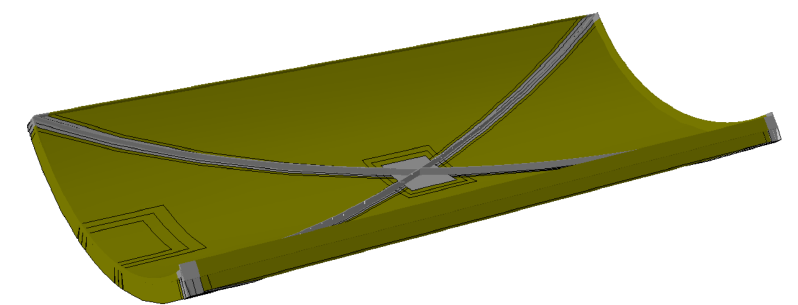
Figure 16. Structural design of the load-bearing composite sandwich structure carrying the ablative TPS with reinforcements in form of an X-shaped frame and beams along the outer